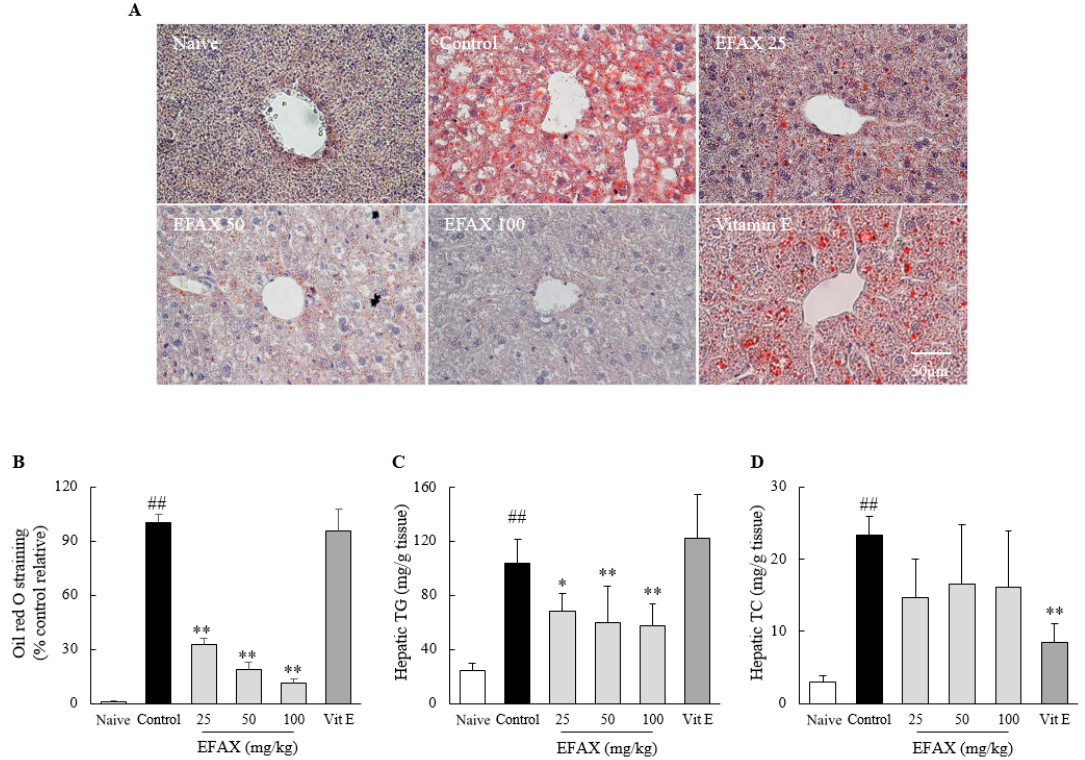
Figure 2. Effects on hepatic lipid profiles. Mice ( n = 8 in each group) were fed a 60% high fat diet for 8 weeks excluding naive group (normal chow diet). From the 3rd week of high fat diet feeding, distilled water (control), EFAX (25 mg/kg, 50 mg/kg, 100 mg/kg), and vitamin E (100 mg/kg) were administered by gavage daily for the last 6 weeks. Oil Red O staining ( A ) of liver sections was performed, and representative photographs (400× magnification) were semi-quantified ( B ). Hepatic levels of Hepatic triglyceride (TG) ( C ) and total cholesterol (TC) ( D ) were evaluated. ## p < 0.01 compared with the naive group; ∗ p < 0.05, ∗∗ p < 0.01 compared with the control group.